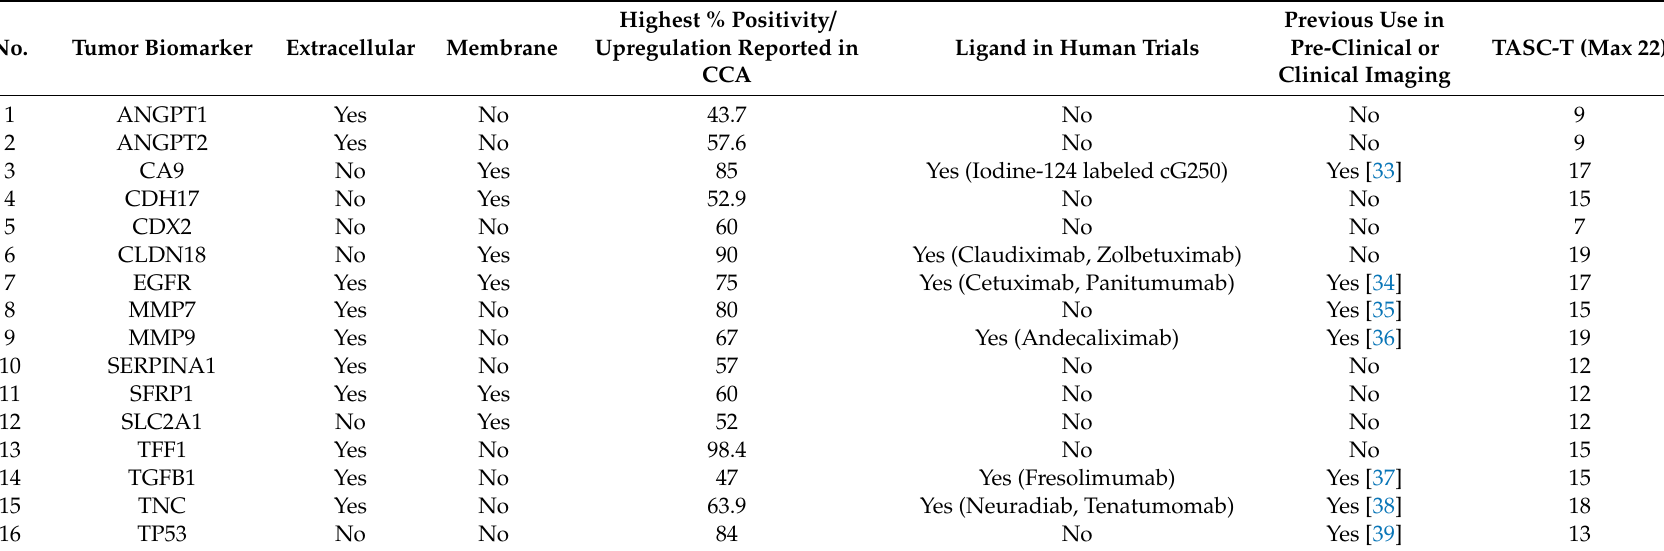
Table 2. TASC-T scoring of 16 selected biomarkers validated in ≥ 2